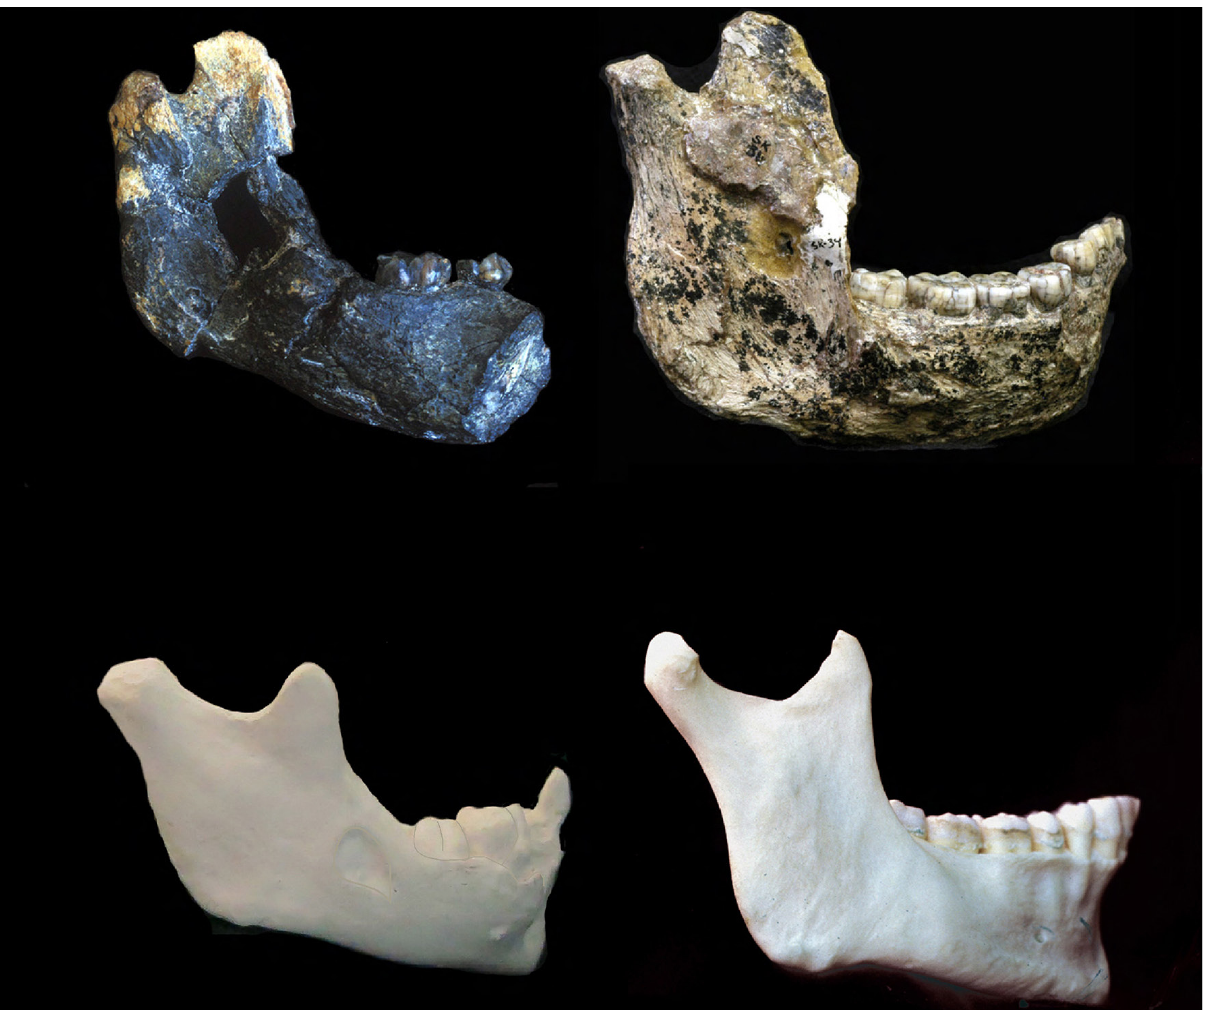
Figure 3: Comparison of ramal morphology in four mandibles (not shown to scale). Upper: juvenile Australopithecus specimen A.L. 33343 (left) and adult Australopithecus specimen SK 34 (right). Lower: juvenile Homo sapiens mandible (left) and adult H. sapiens mandible (right). Note that the upper part of the ramal morphology is the same in the juvenile specimen and its corresponding mature specimen in both pairs. In the Australopithecus mandibles, the coronoid process is taller than the condylar process; the mandibular notch between them is confined and asymmetric; and its deepest point is very close to the condylar process. This configuration is quite different from that of H. sapiens , in which the two processes are the same size in the juvenile and the adult; the mandibular notch is wide; and the deepest point of the notch is midway between the condylar and coronoid